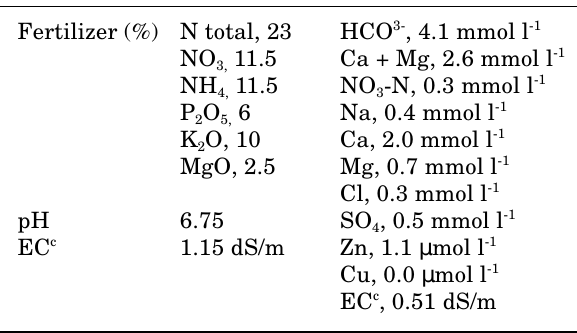
Table 2. Details on water, fertilizers and nutrient solu- tion used in the closed soilless system trial (Albenga,